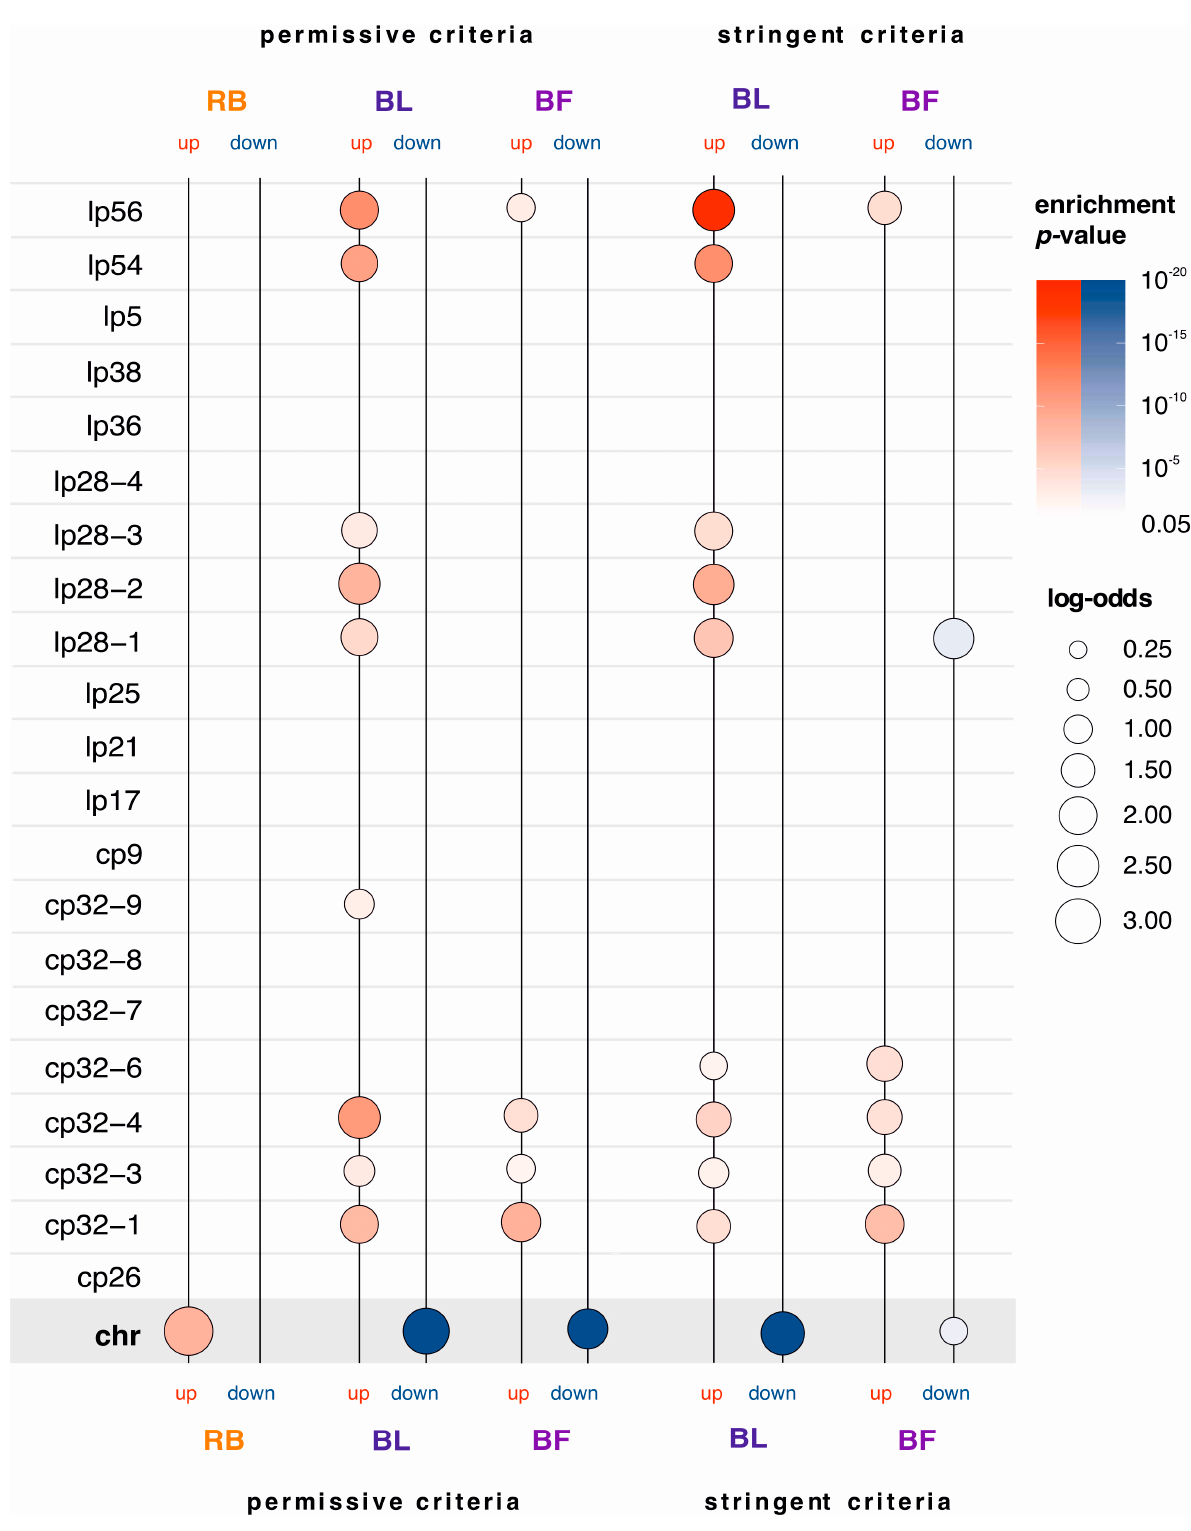
Figure 4. The genome localization enrichment analysis of differentially expressed genes in B. burgdorferi morphotypes. We showed the enrichment profiles of genome locations for upregulated (up, red